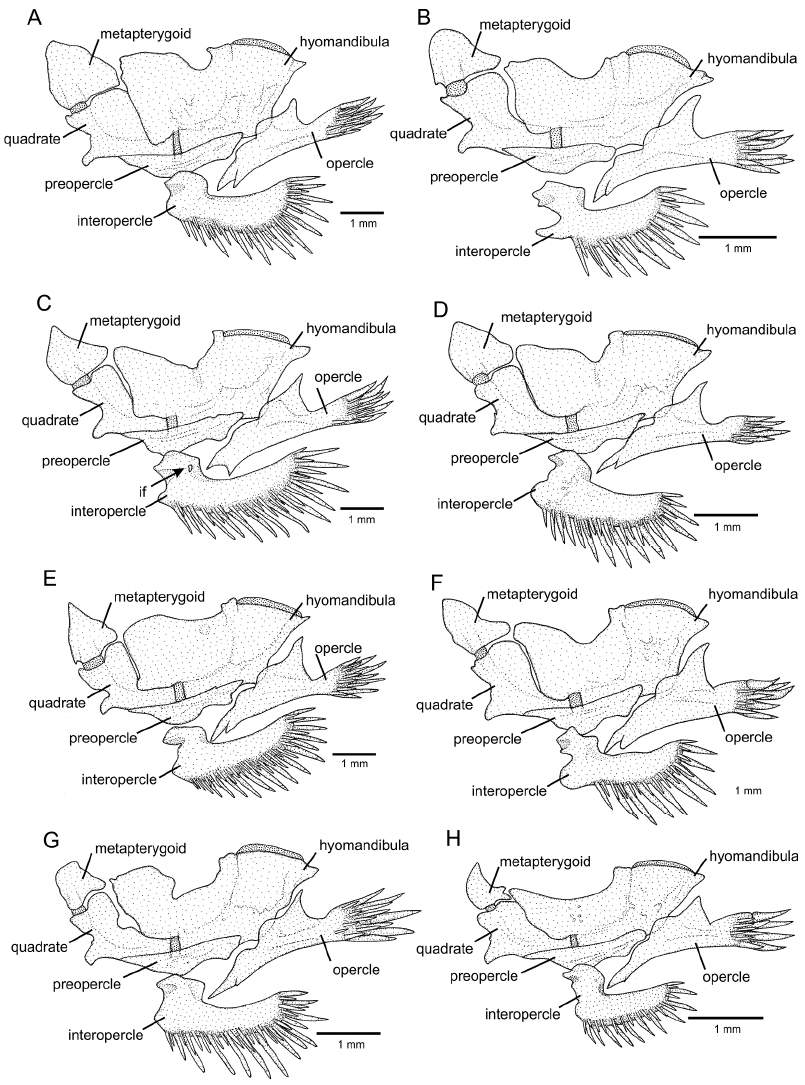
Figure 6. Left jaw suspensorium and opercular series, in lateral view: ( A ) Trichomycterus (Cryptocambeva) garbei Costa, Azevedo-Santos & Ka tz sp. nov.; ( B ) Trichomycterus (Cryptocambeva) listruroides Costa, Ka tz & Azevedo-Santos sp. nov.; ( C ) Trichomycterus (Cryptocambeva) pirabitira ; ( D ) Trichomycterus (Cryptocambeva) mirissumba ; ( E ) Trichomycterus (Cryptocambeva) saturatus Costa, Ka tz & Azevedo-Santos sp. nov.; ( F ) Trichomycterus (Cryptocambeva) uberabensis Costa, Azevedo-Santos & Ka tz sp. nov.; ( G ) Trichomycterus (Paracambeva) adautoleitei Costa, Ka tz & Azevedo-Santos sp. nov.; and ( H ) Trichomycterus (Paracambeva) coelhorum Costa, Azevedo-Santos & Ka tz sp. nov. Larger stippling represents cartilage. Laterosensory system: In the supraorbital region, the posterior section of the infraorbital canal and postorbital canal is continuous. There are three supraorbital sensory canal pores: s1 is adjacent to the medial margin of the anterior nostril; s3 is adjacent and